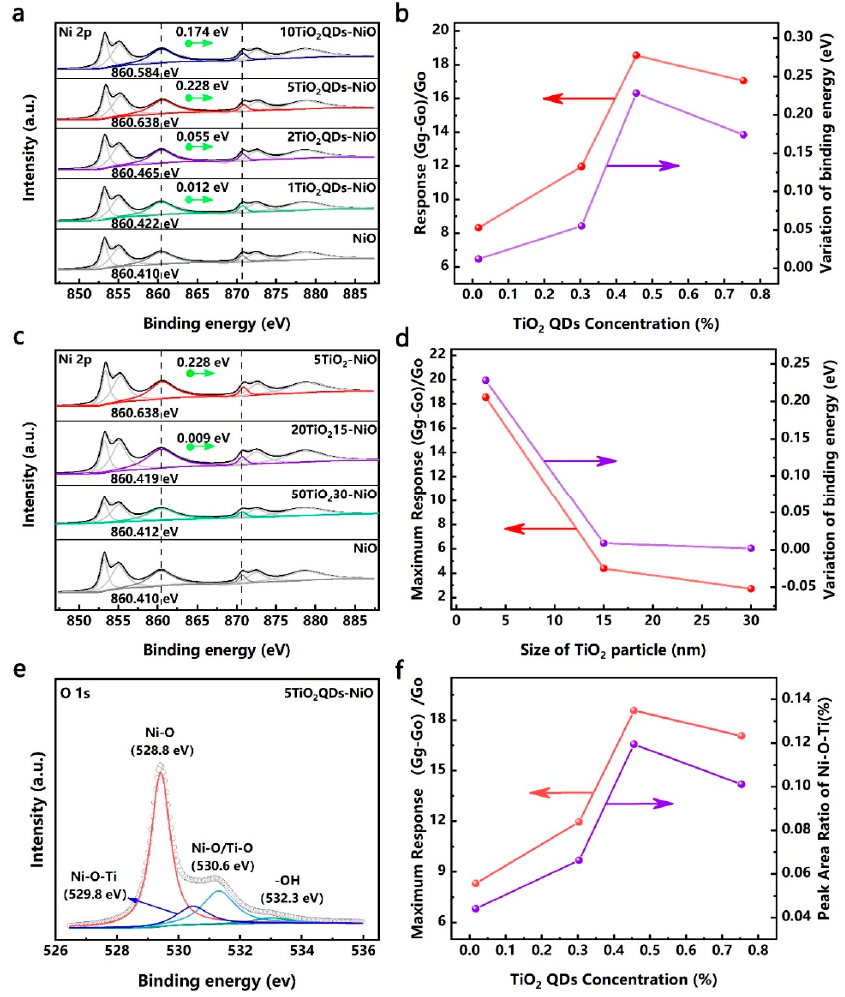
Figure 4. ( a ) Ni 2p spectra of the bare NiO and the TiO 2 QDs-NiO nanohybrids. ( b ) With the increase of the TiO 2 QDs content, a comparison between the variation of the responses to 60 ppm NO 2 and the variation of the binding energy shift values is shown. ( c ) Ni 2p spectra of the bare NiO and the 5TiO 2 QDs-NiO, 20TiO215-NiO, and 50TiO230-NiO. ( d ) With the increase of the TiO 2 nanoparticle size, a comparison between the variation of the maximum responses to 60 ppm NO 2 and the variation of the binding energy shift values is shown. ( e ) O 1s spectra of the 5TiO 2 QDs-NiO. ( f ) With the increase of the TiO 2 QDs content, a comparison between the variation of the responses to 60 ppm NO 2 and the variation of the peak area ratio of Ni-O-Ti is shown.